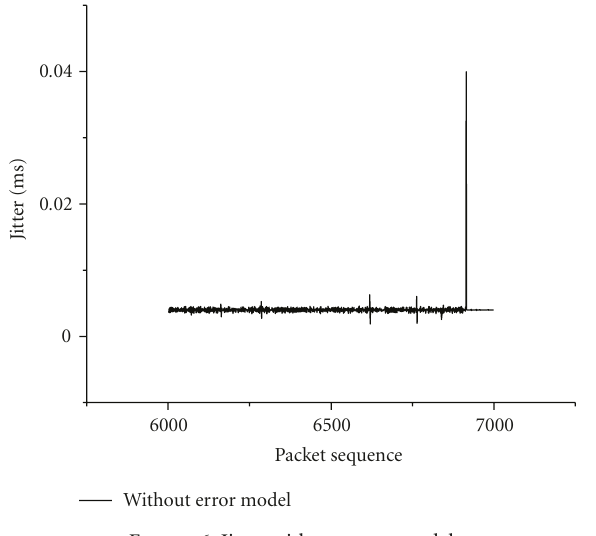
Figure 6: Jitter without error model. Figure 7: Jitter with error